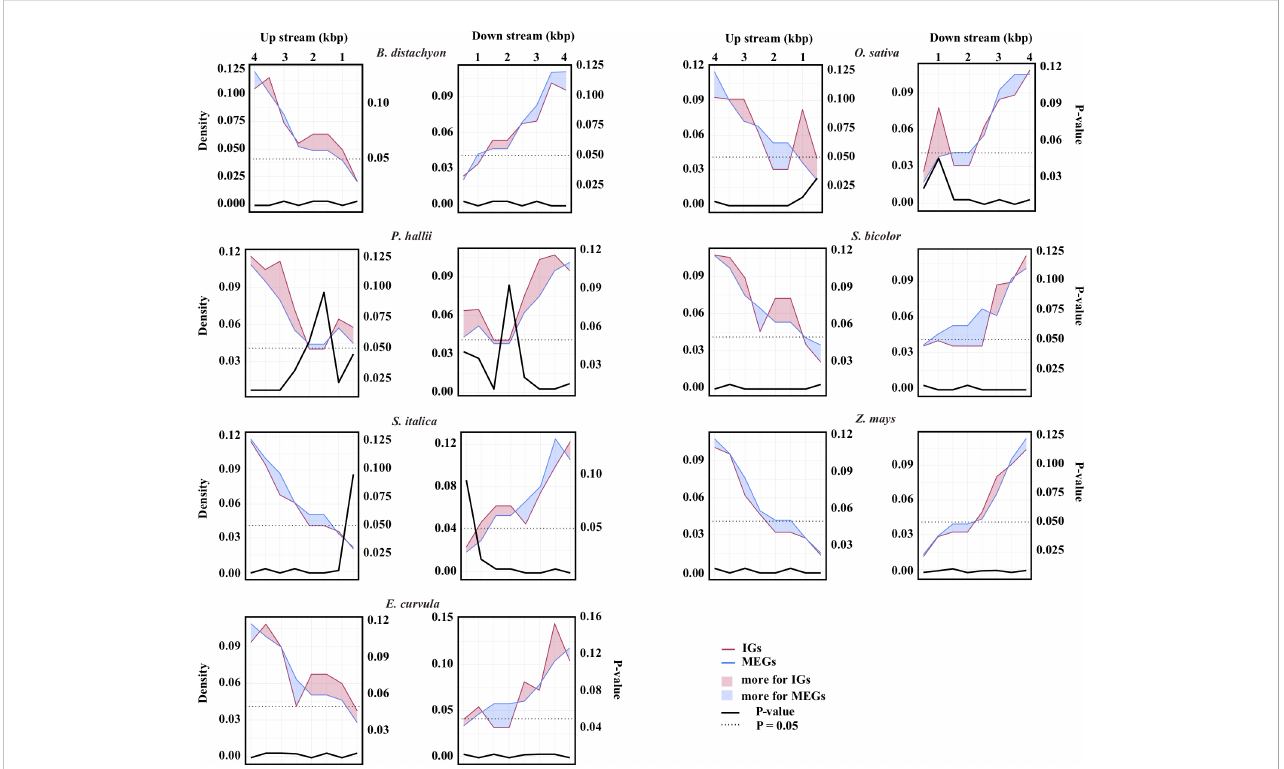
FIGURE 2 Retrotransposon landscape surrounding genes. Retrotransposon density around IGs (red line) or multiexon genes (MEGs, blue line). The number of retrotransposons was determined in 100-bp windows and averaged for every 500-bp window from the transcription start site to 4 kb upstream and from the transcription termination site to 4 kb downstream. The data were normalized according to the number of IGs or MEGs. The left y-axis shows the normalized density. The red area indicates that there are more retrotransposons for IGs than for MEGs in that region, whereas the blue area indicates the opposite. The source data are provided in Supplementary Table S2. The differences in the number of retrotransposons between the IGs and the MEGs were assessed by a two-sided paired Wilcoxon sign test. The right y-axis shows the P